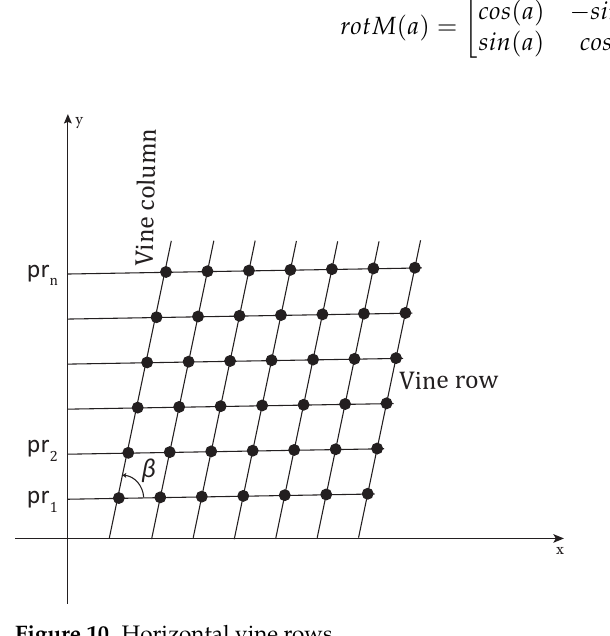
Figure 10. Horizontal vine rows.